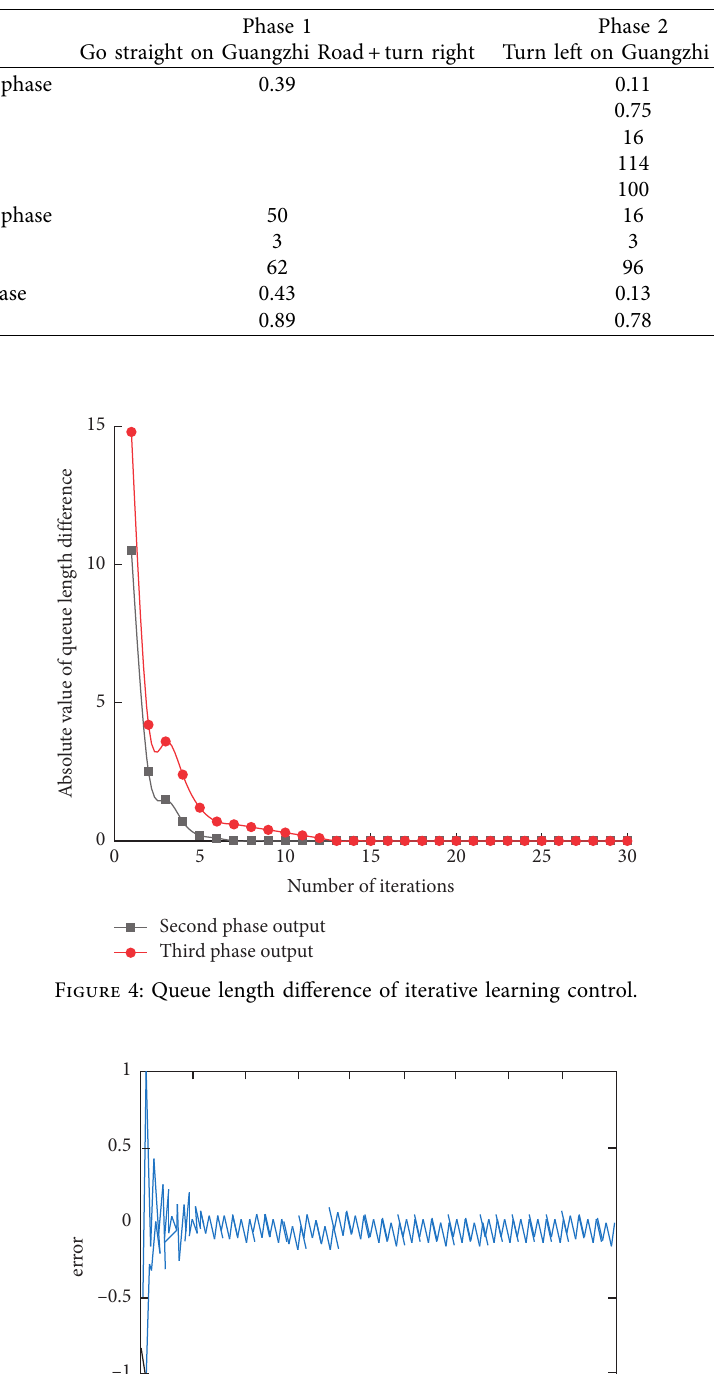
Table 3: Time allocation plan after the intersection signal optimization.